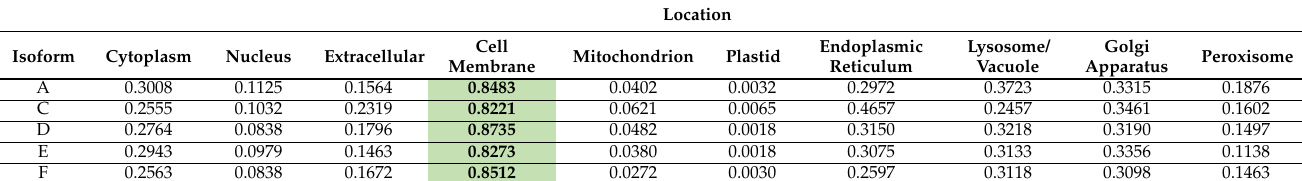
Table 4. Subcelullar localizations of FCRL6A and C – F in D. novemcinctus predicted by DeepLoc 2.0. Location